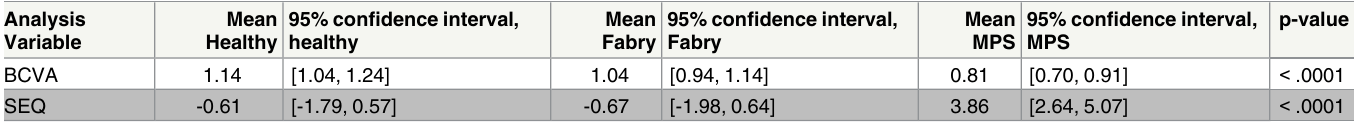
Table 2. Mean (estimated from linear mixed effectsmodel) and corresponding 95% confidence interval of BCVA (decimal), spherical equivalent refraction (SEQ) and p-values. Analysis Variable